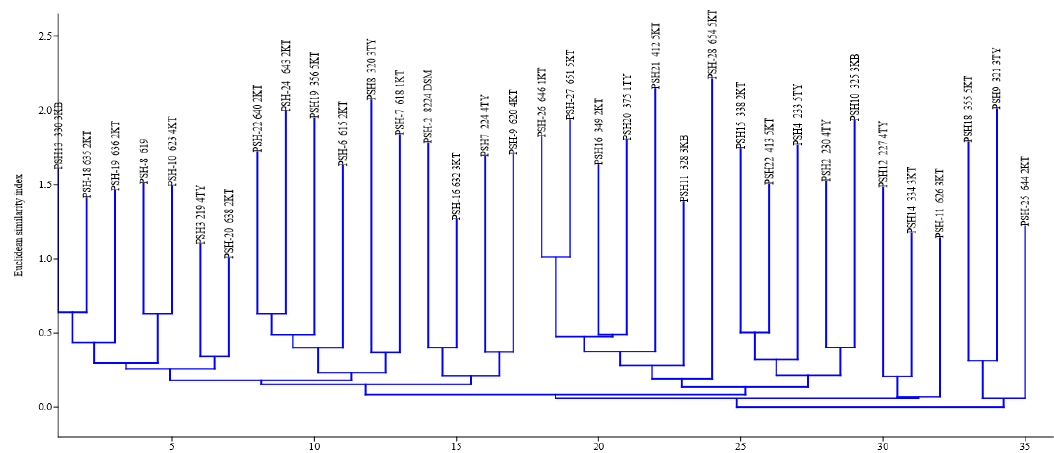
Figure 6. A neighbor-joining dendrogram cluster of (GTG)5-PCR fingerprints of P. shigelloides strains. Isolates were encoded, for example, PSH-15 338 2KT, representing strain number (PSH-15), assigned number for PCR confirmed (338), and origin of the isolate (2KT).